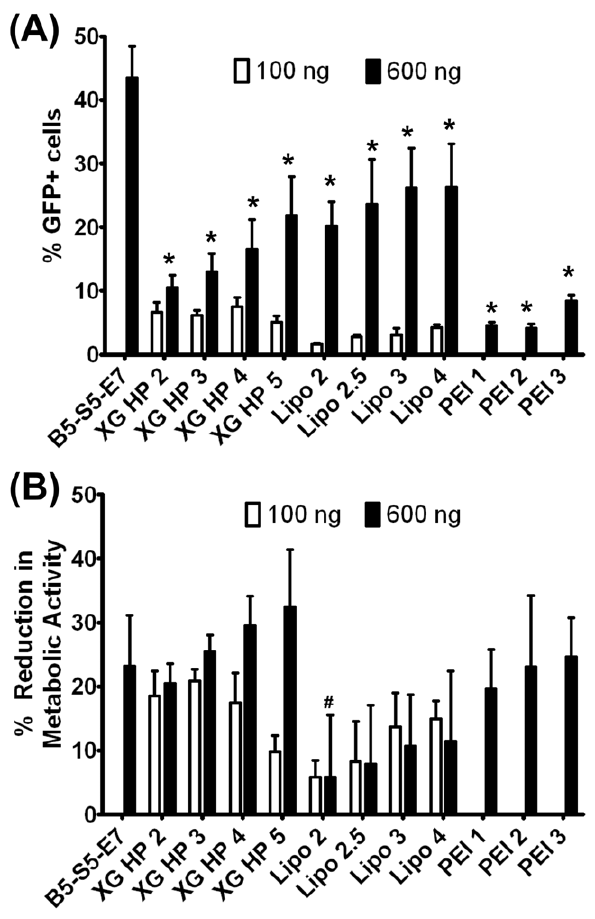
Figure 6. Comparison to commercially available transfection reagents. (XG HP=XtremeGENE HP; Lipo=Lipofectamine 2000; PEI=25 kDa branched polyethyeleneimine). The numbers next to the reagent name corresponds to the ratio of lipid (v/v) or polymer (w/w) to DNA used. (A) Transfection efficacy of control formulations and B5-S5- E7 at 60 w/w (n=4); * indicates p , 0.001 vs. B5-S5-E7 at 60 w/w. (B) Reduction of metabolic activity of control formulations and B5-S5-E7 at 60 w/w (n=4); # indicates p , 0.05 vs. B5-S5-E7 at 60